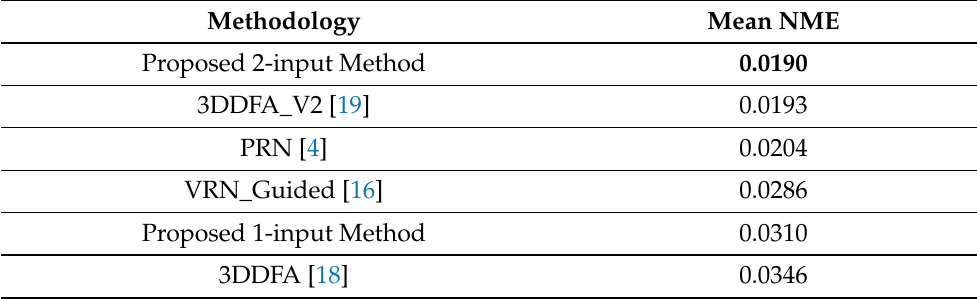
Table 4. Mean NME for various models. Best performance is highlighted in